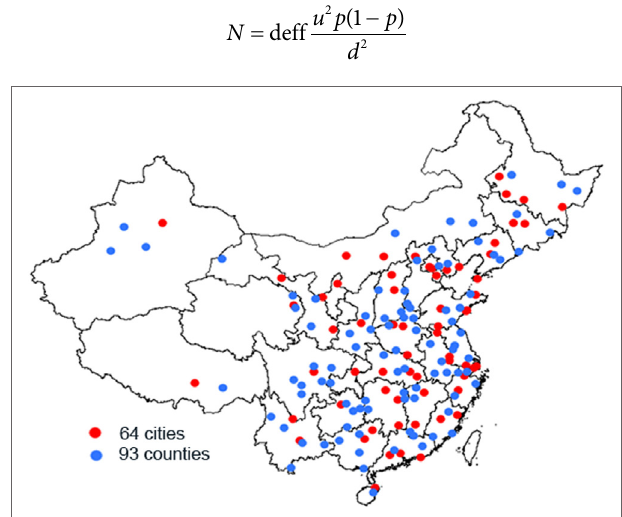
FigUre 1 | Distribution of survey sites in 31 provinces of China.